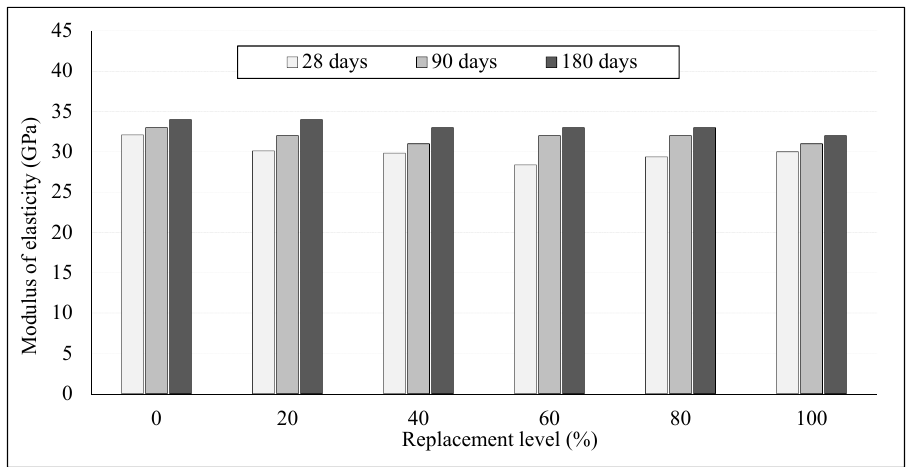
Figure 24. Development of modulus of elasticity of POCP concretes.